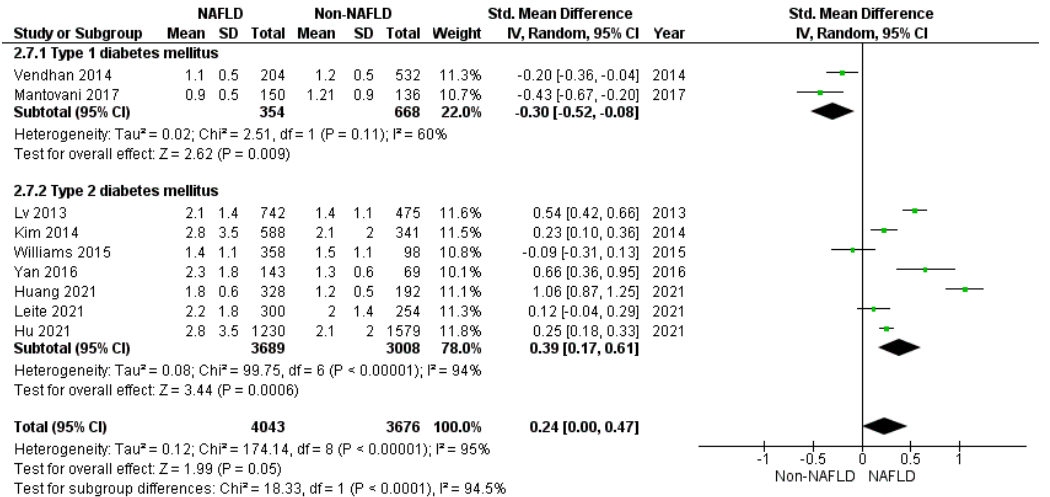
Figure 6. Forrest plot displaying triglycerides serum levels expressed in mmol/L, comparing diabetic patients with and without NAFLD. Data are expressed as a standard mean difference, evaluated by applying the random effect model.